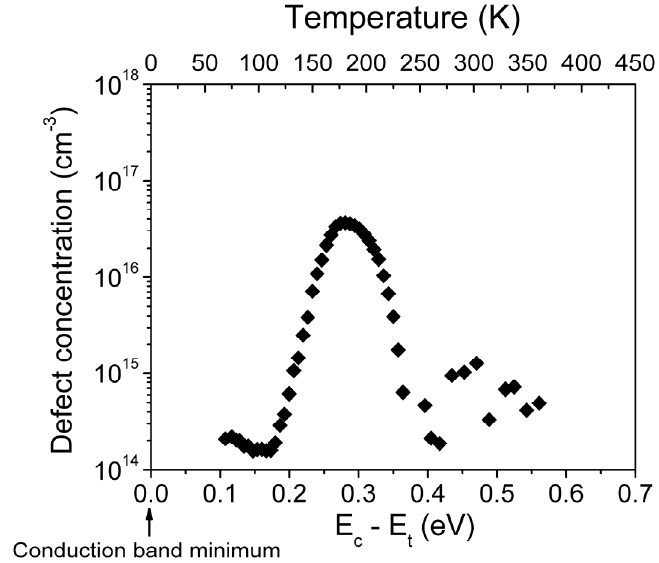
Figure 6. (Color online) The correspondent subgap density of states as a function of defect energy from the conduction band.